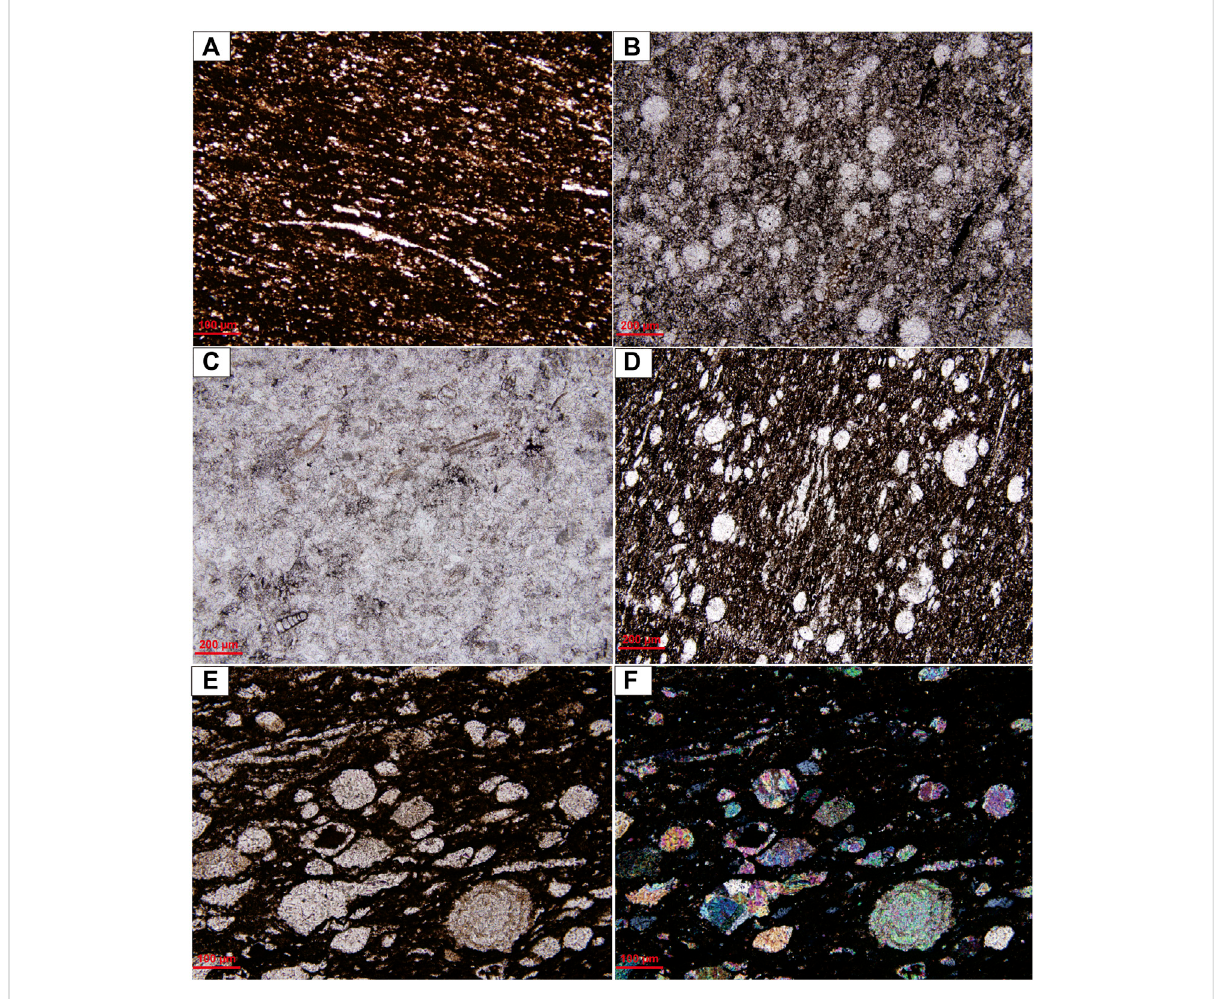
FIGURE 4 Lithological microscopic photos of theDalong Formation. (A) Bioclastic siliceous shale, biodetritus aligned in a directional manner. (B) Calcium spheres, the calcium spheres are not uniform in size. (C) Bioclastic limestone, such as foraminifera, brachiopod, ostracod, and gastropod. (D) Radiolarian,and (E) Spherules fi lledwithorganicmatterbypolarizingmicroscopewithplanepolarizedlight. (F) spherules fi lledwithorganicmatterby polarizing microscope with perpendicular polarized